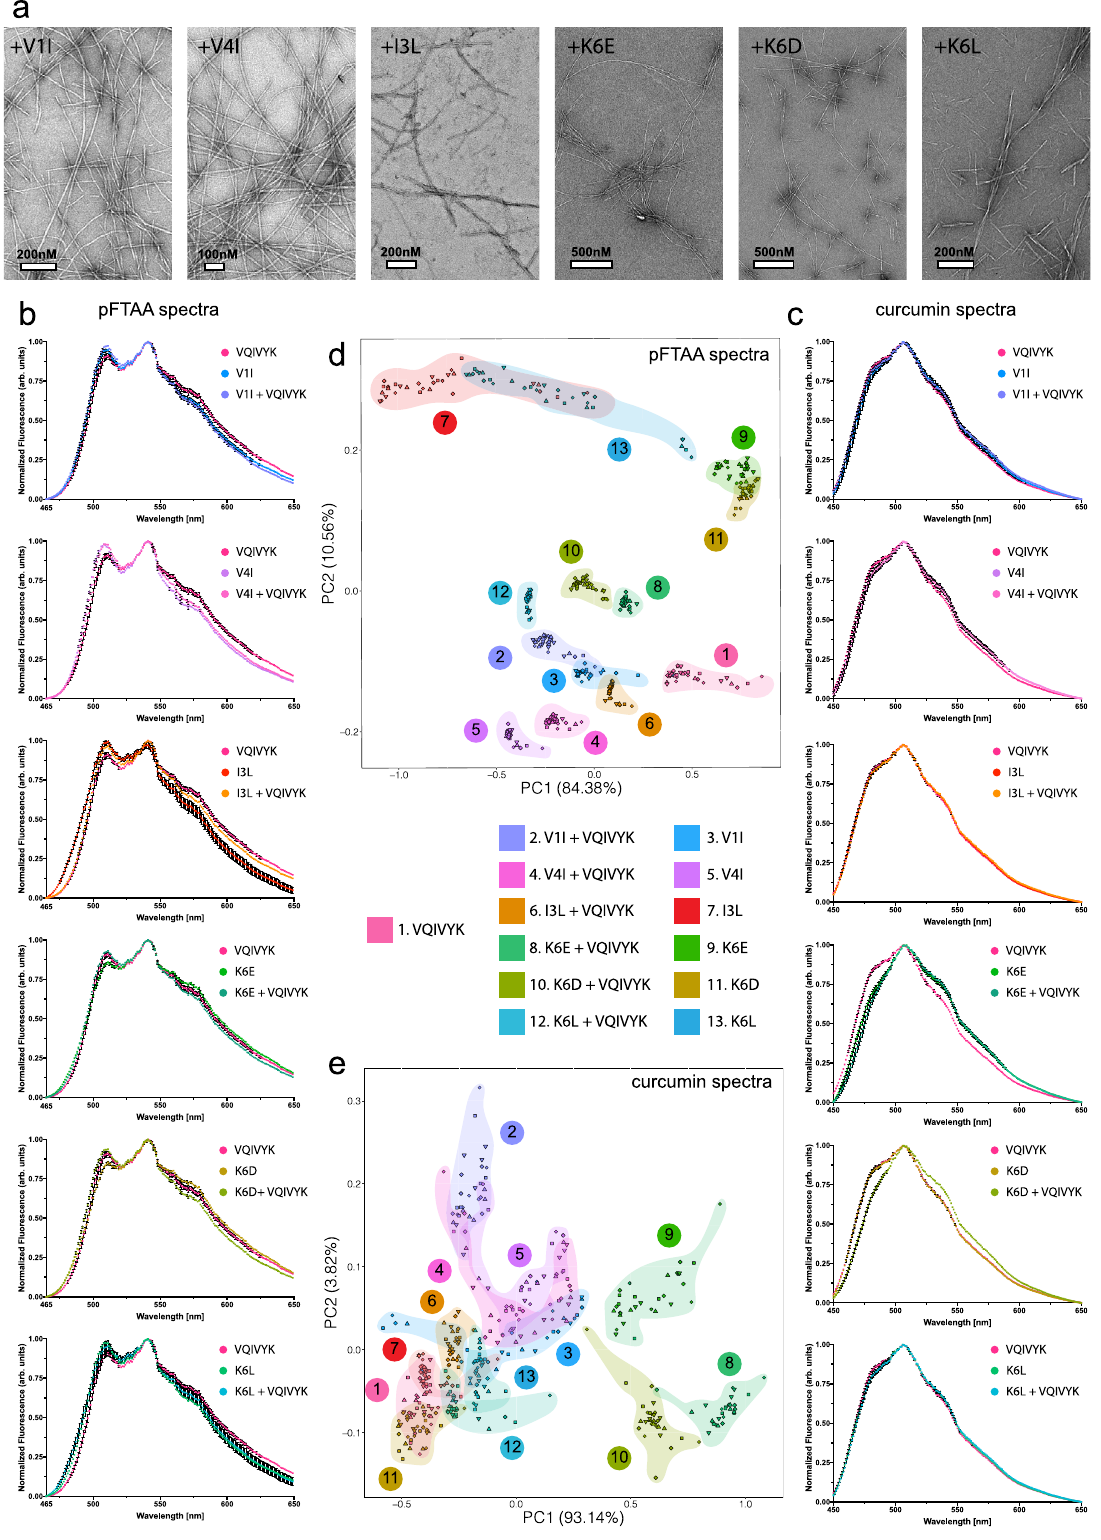
Fig. 6 Morphological differentiation induced by co-aggregating sequence-dependent variants of the VQIVYK aggregation prone peptide. a Electron micrographs indicate that co-aggregating sequences modify the morphology of amyloid fi brils formed compared to the VQIVYK-alone fi brils. b , c Normalised binding spectra of b pFTAA and c curcumin ampli fi ed from fi brils derived from mix, peptide modi fi er-alone or VQIVYK-alone samples. Data points are shown as mean values ± SD. d , e PCA of the derived d pFTAA and e curcumin spectra highlighted the distribution of heterogenic conformers that cluster in the de fi ned eigen space. For each sample, six individual preparations were split in fi ve independent aliquots and combined in thirty data points ( n = 30) per sample in order to represent the intrinsic variability in the fl uorescence measurements. Source data are provided as a Source Data fi